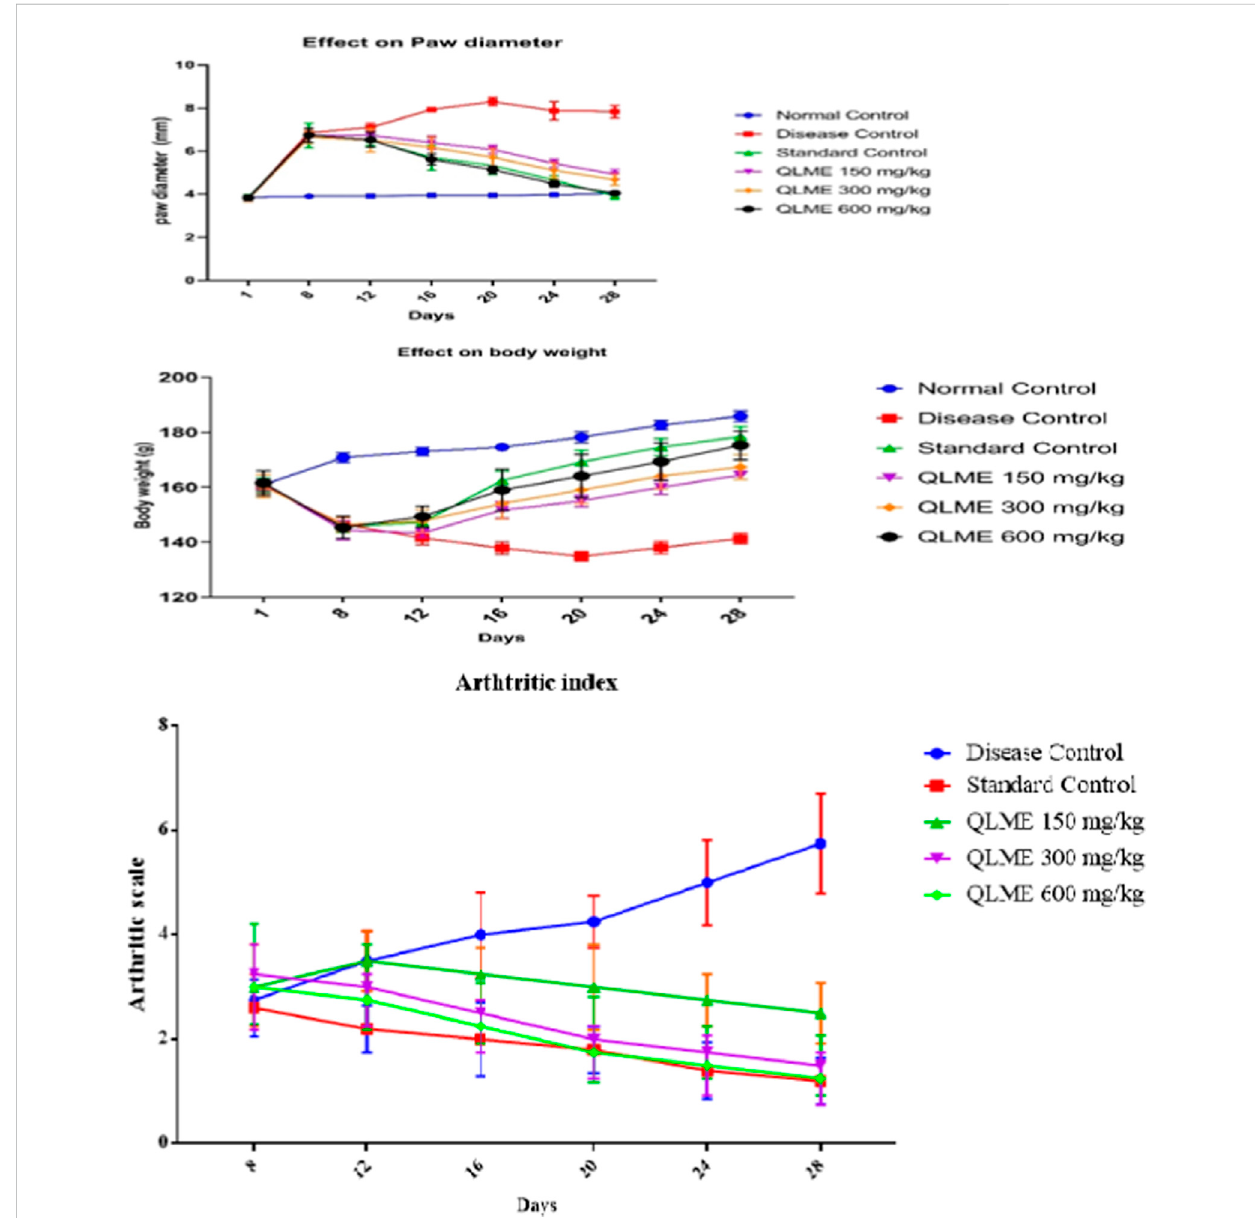
Effect of Quercus leucotrichophora extracts on paw diameter, body weight (g), and arthritic index in CFA-induced arthritic rats. Results as mean ± S.D. (n = 6). Analyzed by two-way ANOVA followed by Tukey ’ s test. QLME: Quercus leucotricophora methanolic extract.